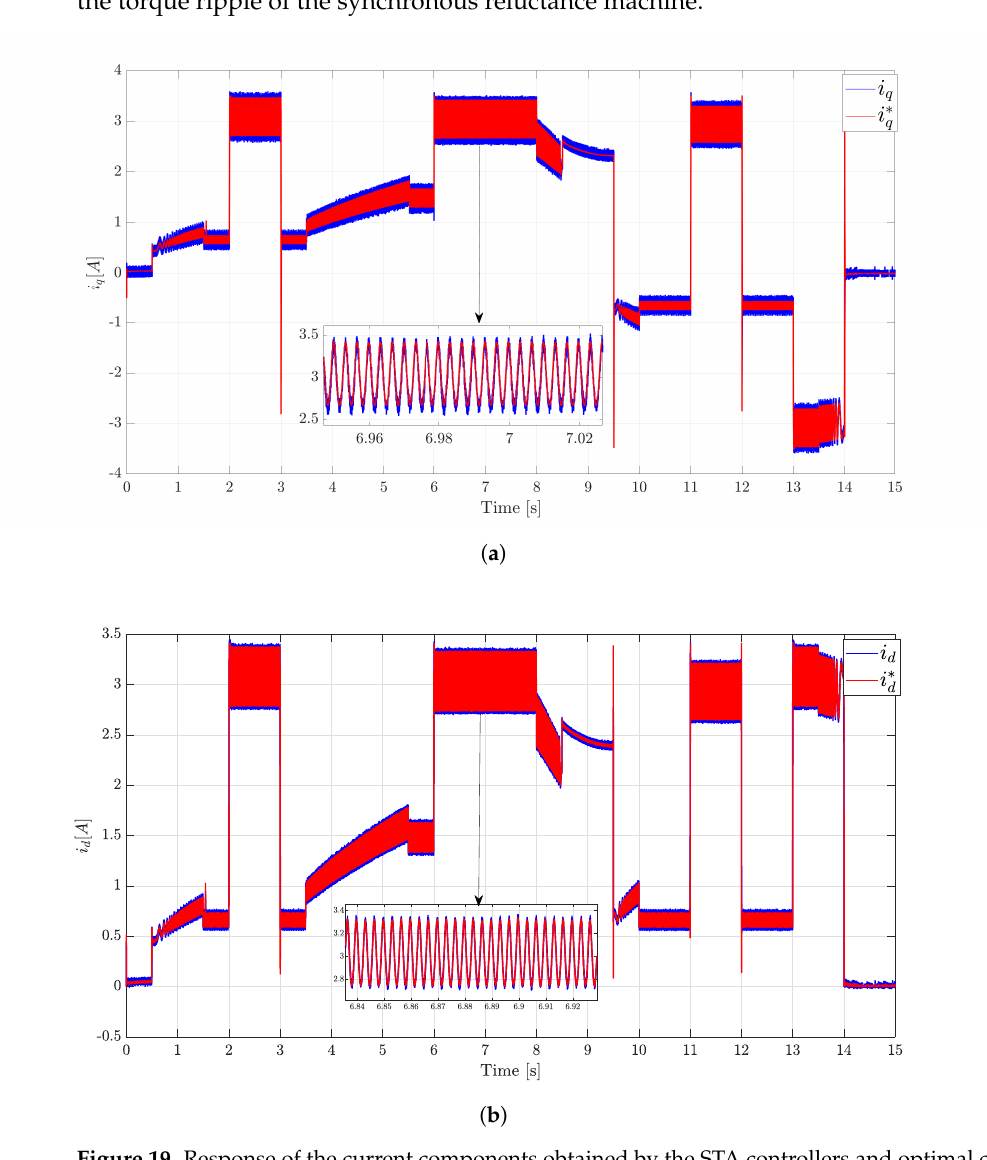
Figure 19. Response of the current components obtained by the STA controllers and optimal currents calculations method: ( a ) i q response and ( b ) i d